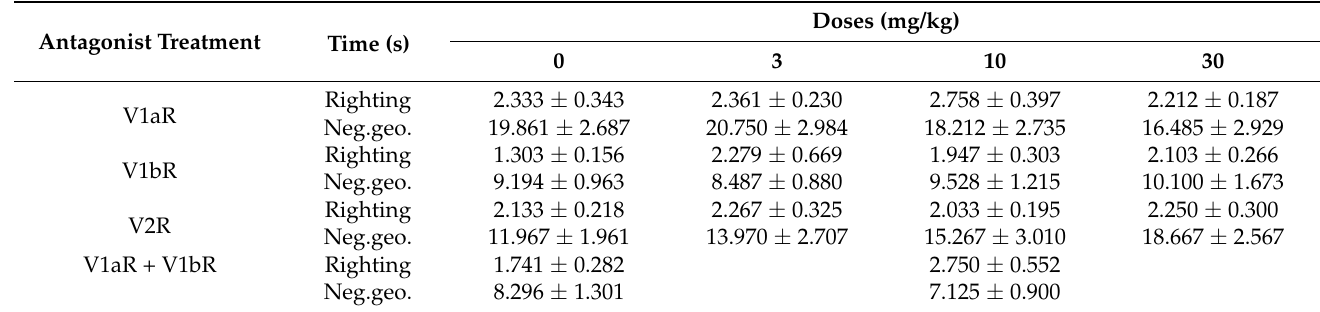
Table 1. Righting reflex and negative geotaxis